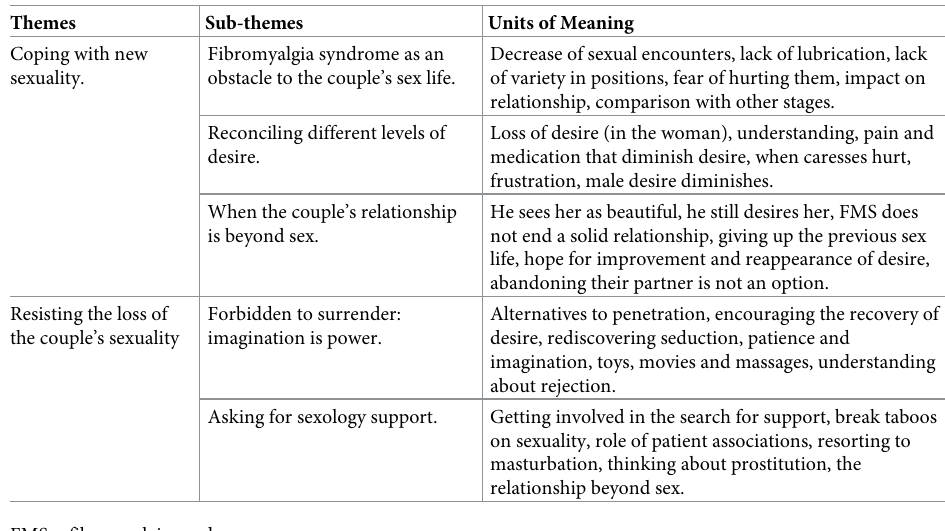
Table 2. Themes, sub-themes and units of